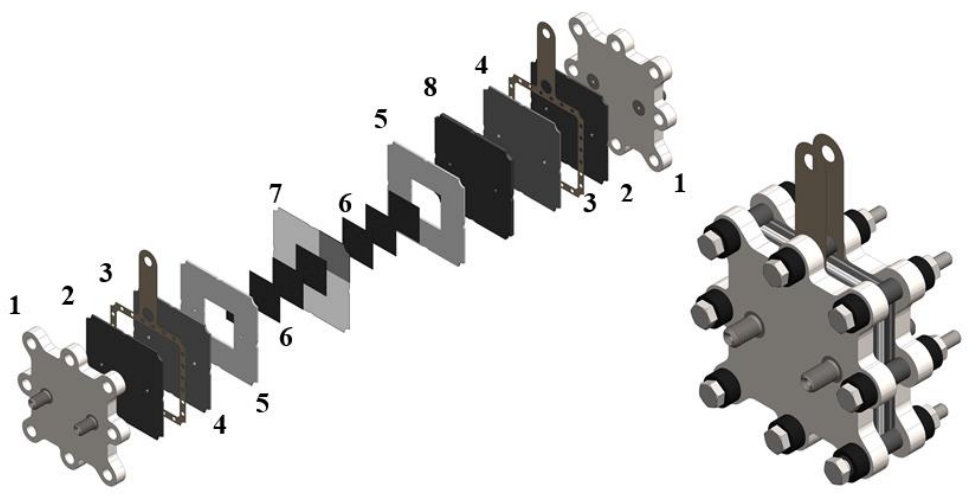
Figure 1. Scheme of hydrogen-bromate flow battery in the disassembled (centered) and assembled (bottom right) states: 1—end plates with fittings; 2—Viton gasket, 3—current collectors, 4—graphite foil, 5—electrode gaskets, 6—carbon paper electrode, 7—proton-exchange membrane with a pressed gas diffusion layer with a platinum catalyst (Pt/C loading 1 g/cm 2 ), 8—glassy carbon plate (LLC El 6, Russia) with holes for electrolyte flow.